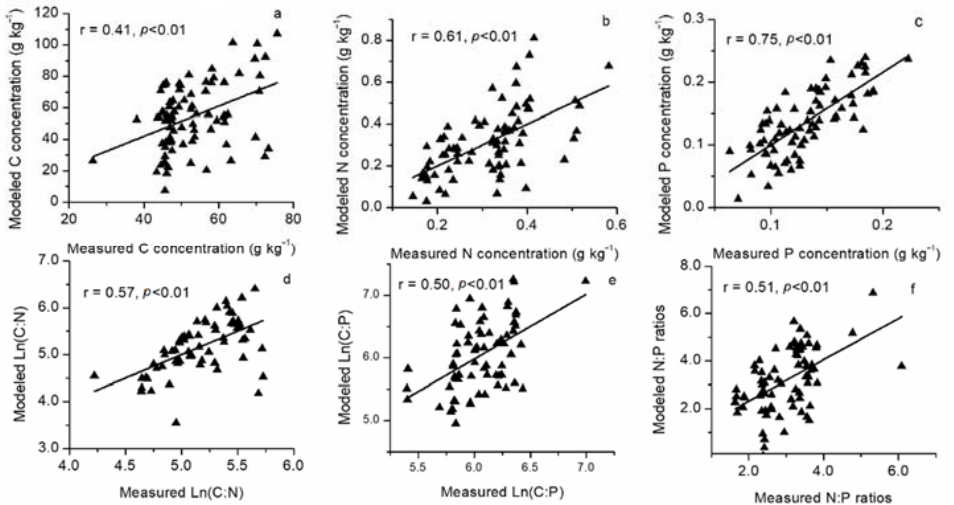
Figure 4. Correlation between estimated and measured C ( a ), N ( b ) and P ( c ) concentrations, and stoichiometric ratios ( d , e and f for C:N, C:P and N:P, respectively) at the sampling plots. C:N and C:P ratios were log ‐ transformed values